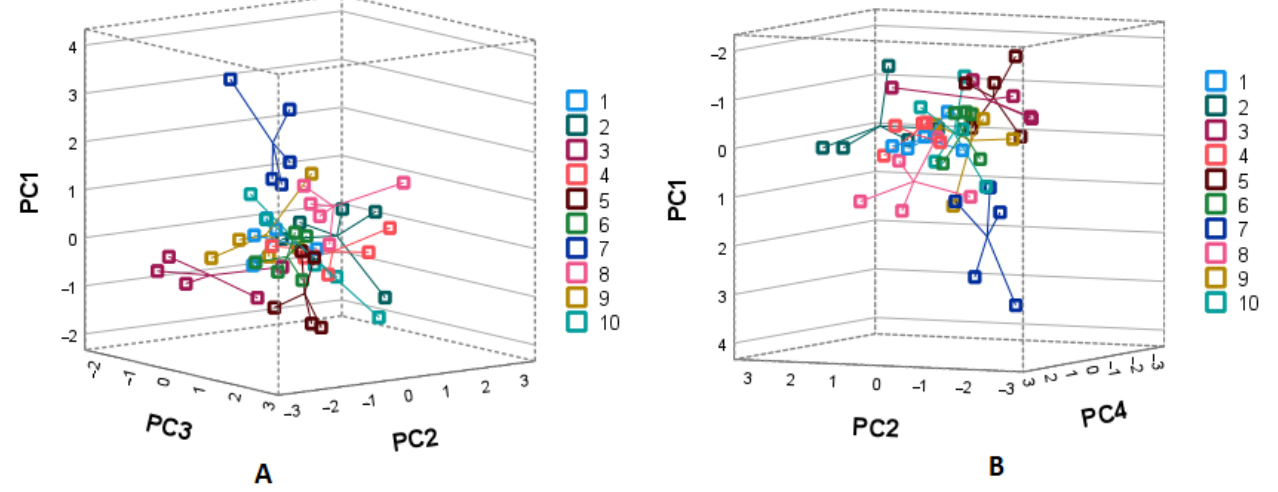
Figure 4. PCA loading plots of triterpenic compound variables (( A )—PC1, PC2, and PC3; ( B )—PC1, PC3, and PC4). 1—Jankai; 2—Zapyskis; 3—Kalnenai; 4—Sudargas; 5—Gerdziai; 6—Eiciai;